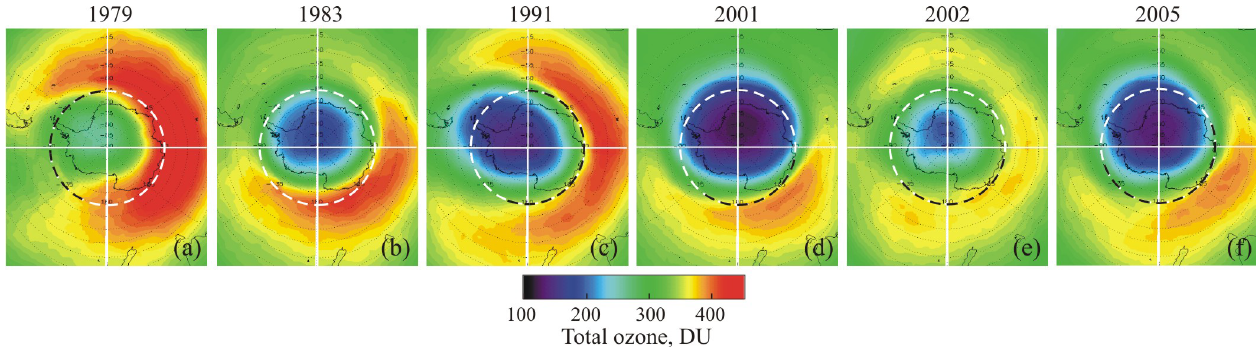
Fig. 1. October mean fields of total ozone over the southern latitudes 45 ◦ S–90 ◦ S obtained from TOMS data. The dashed circle marks latitude 65 ◦